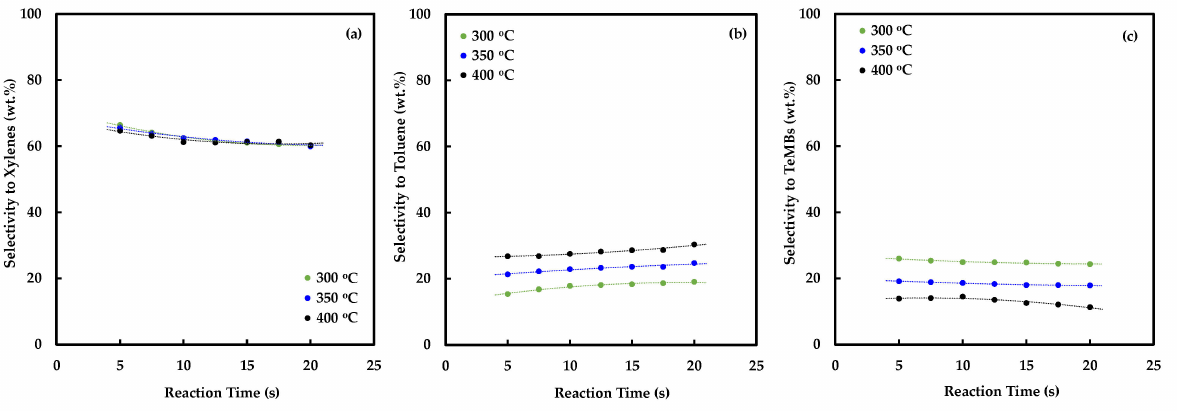
Figure 2. Selectivity towards xylenes ( a ), toluene ( b ) and TeMBs ( c ) as a function of reaction time and